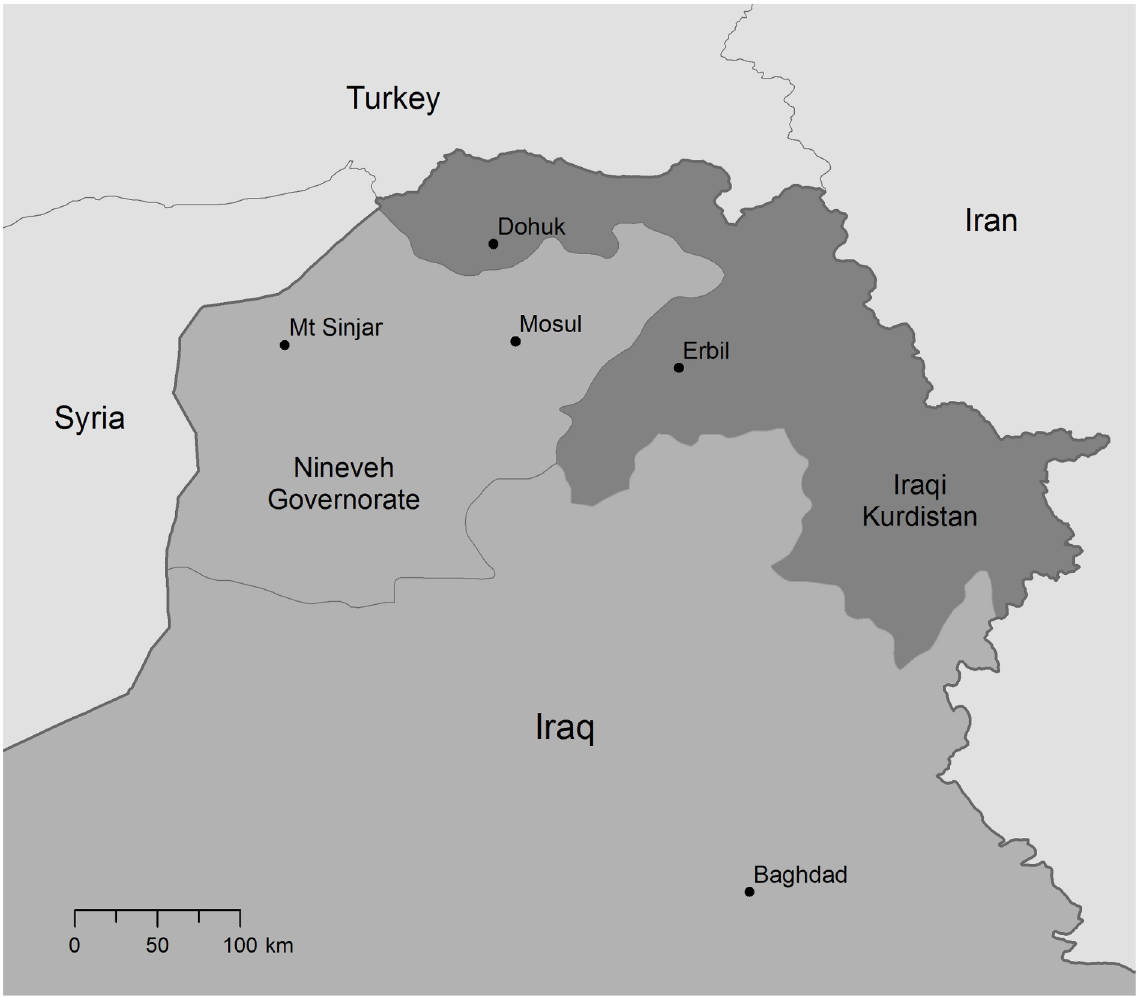
Fig 1. Map of Northern Iraq. Source: Authors’ adaptationof Global Administrative Areas 2.8 (www.gadm.org) and the United States NationalImagery and MappingAgency data